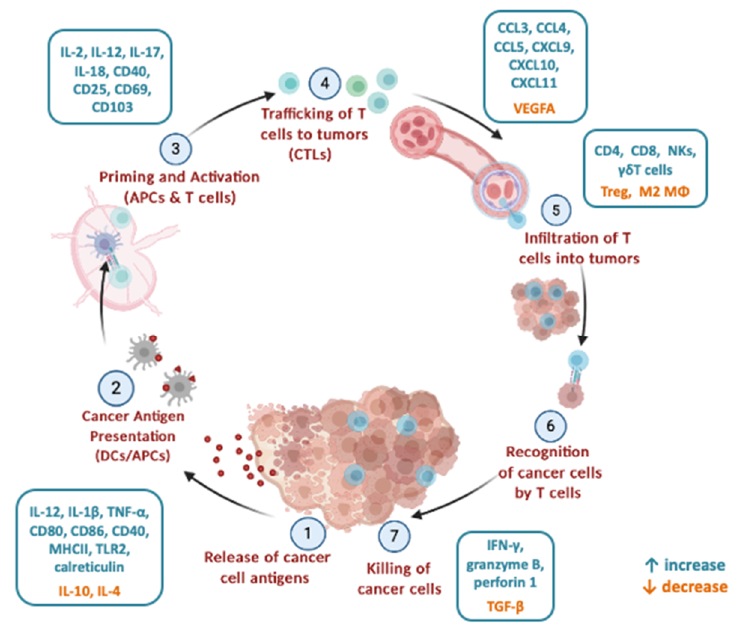
Figure 1. Effect of probiotic bacteria on the cancer–immunity cycle. Probiotic bacteria affect and can modulate different stages in the cancer–immunity cycle, such as cancer antigen presentation, the priming and activation of T cells, the trafficking of T cells to tumours and the infiltration of CD8 + cells into tumours, as well as the killing of cancer cells and release of tumour antigens. Several molecules are upregulated (green-blue color) or downregulated [orange color] following the administration of probiotic bacteria. The cancer–immunity cycle is adapted from [4] and was designed with Biorender (www.biorender.com).